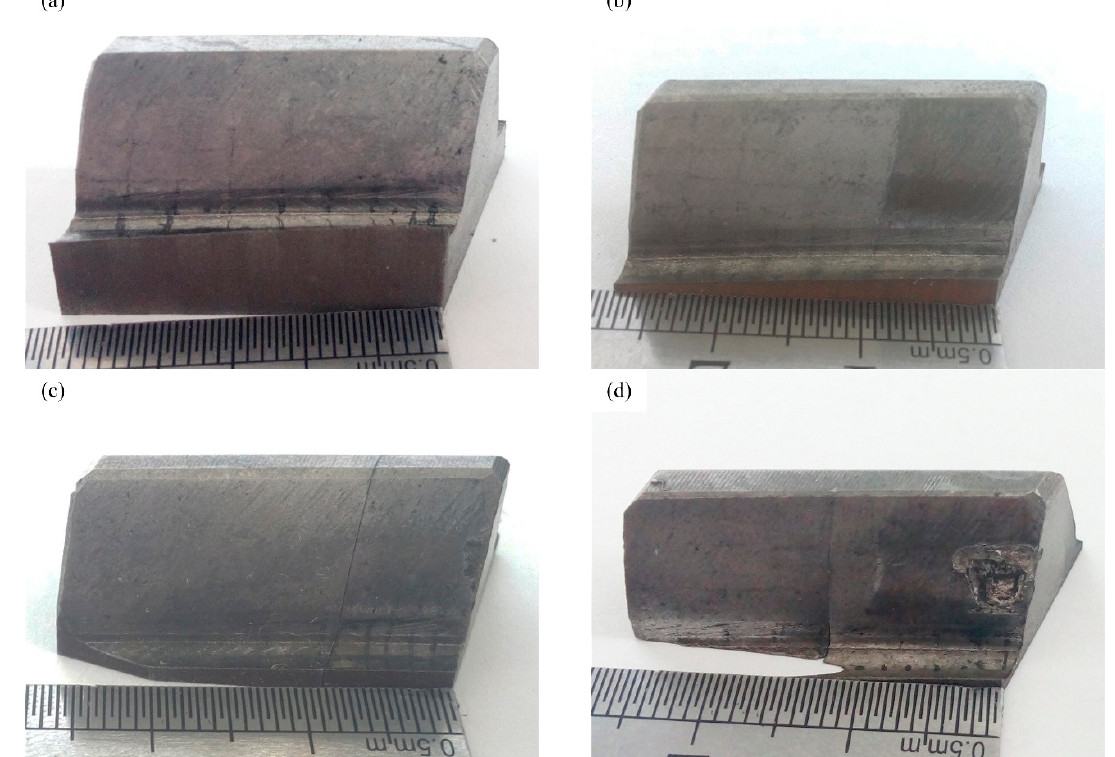
Figure 8. Macroscopic morphology of gears’ teeth: ( a ) gear 1 ‐ 2, ( b ) gear 2 ‐ 2, ( c ) gear 3 ‐ 2, and ( d ) gear 4 ‐ 2.